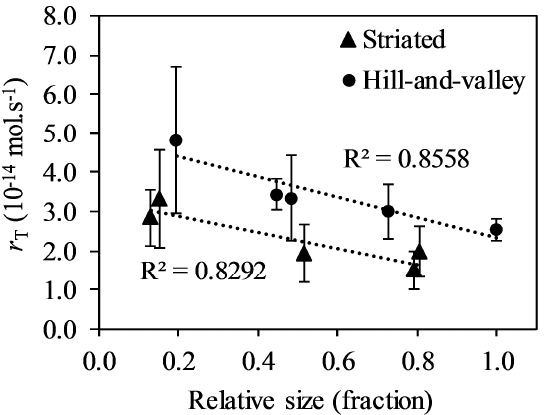
Figure 9. Evolution of total material flux rates as a function of the calcite patches size. Each total material flux rate ( r T ) compiles the average rate from five cement patches maps. Data related to the first two reaction time steps (0–3 h and 3–6 h) were not included because of their apparent relation to polishing defects.